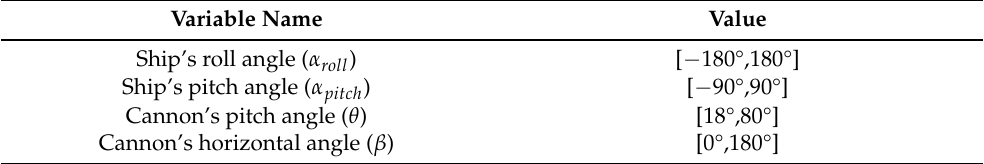
Table 1. Definition of ship motion attitudes and control quantities of water